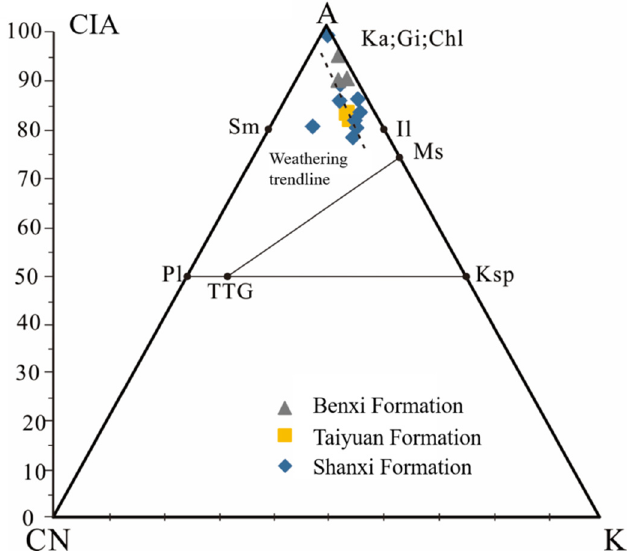
Figure 6. A-CN-K diagram for the Liulin section.